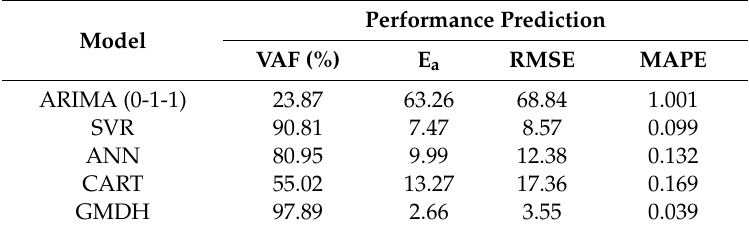
Table 6. The obtained results of performance prediction for testing datasets.